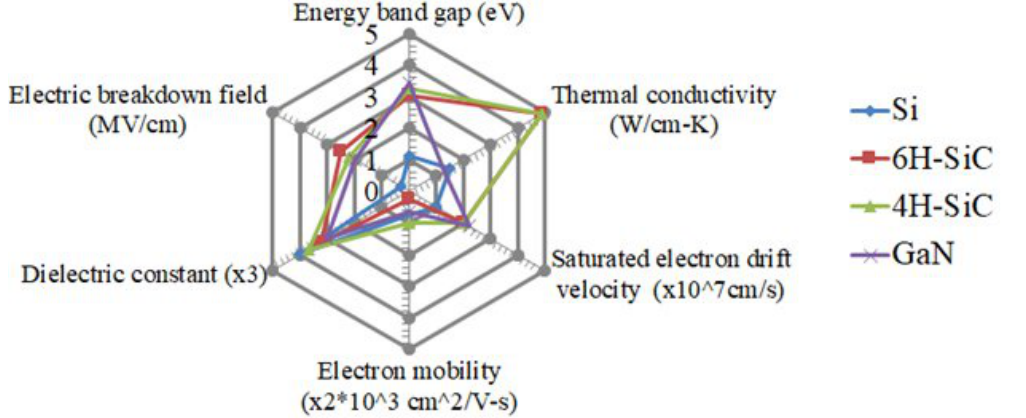
Figure 10. Comparison of wide bandgap